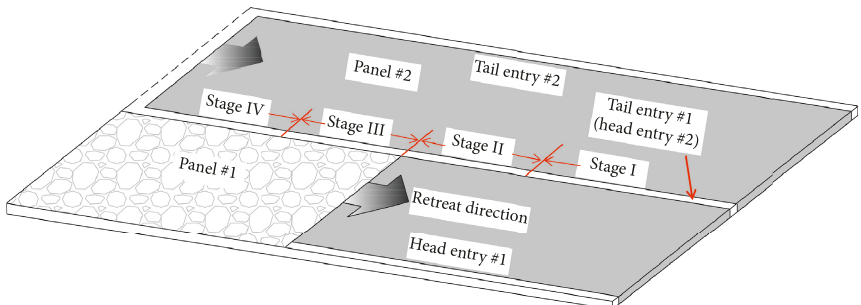
Figure 2: Various stages of the FRME approach for the gob-side entry.